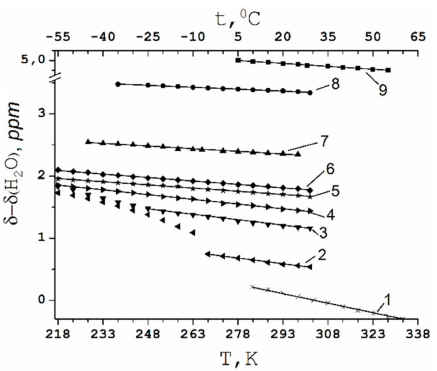
Figure 11. Temperature dependences of 1 H NMR chemical shifts in acid ionic form of Nafion membrane at different water content ( δ H2O is bulk water chemical shift at 25 ◦ C). (1) bulk H 2 O; (2) RH 98% ( λ = 17.5 ± 0.4); (3) RH 95% ( λ = 12 ± 0.4); (4) RH 78% ( λ = 7.4 ± 0.4); (5) RH 64% ( λ = 6.4 ± 0.4); (6) RH 58% ( λ = 5.8 ± 0.4); (7) RH 32% ( λ = 4.4 ± 0.4); (8) RH 10% ( λ = 3.2 ± 0.4); (9) RH